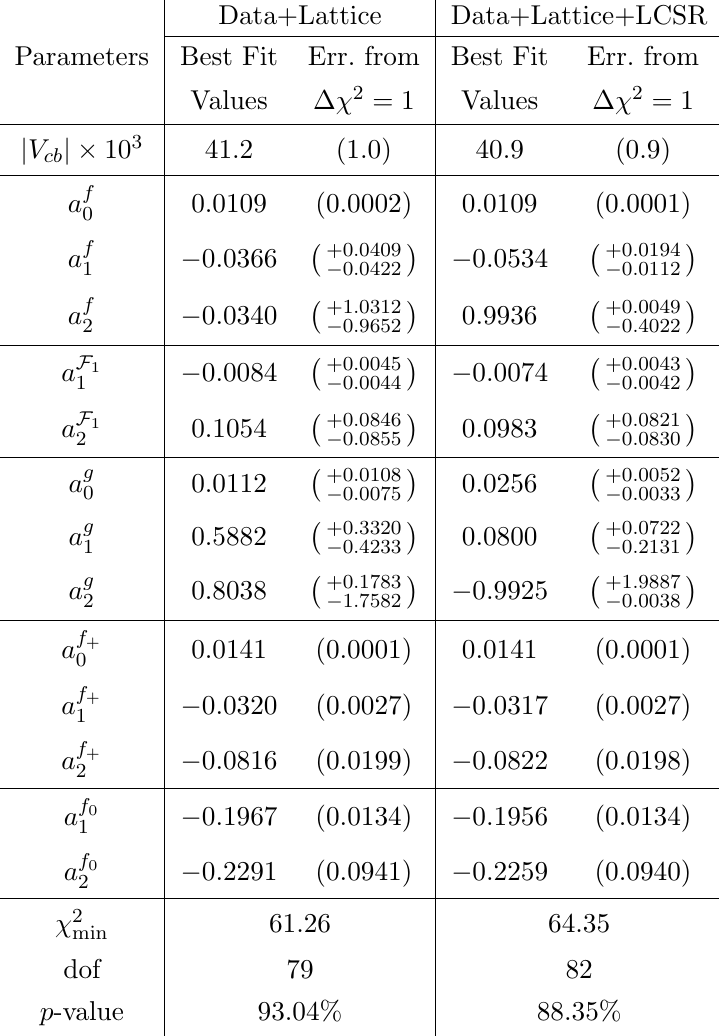
Table 11 . The (cid:12)t results obtained from the combined analysis of the available data in the decays B ! D‘(cid:23) ‘ and B ! D (cid:3) ‘(cid:23) ‘ with the BGL parameterization of the form factors with N = 2.